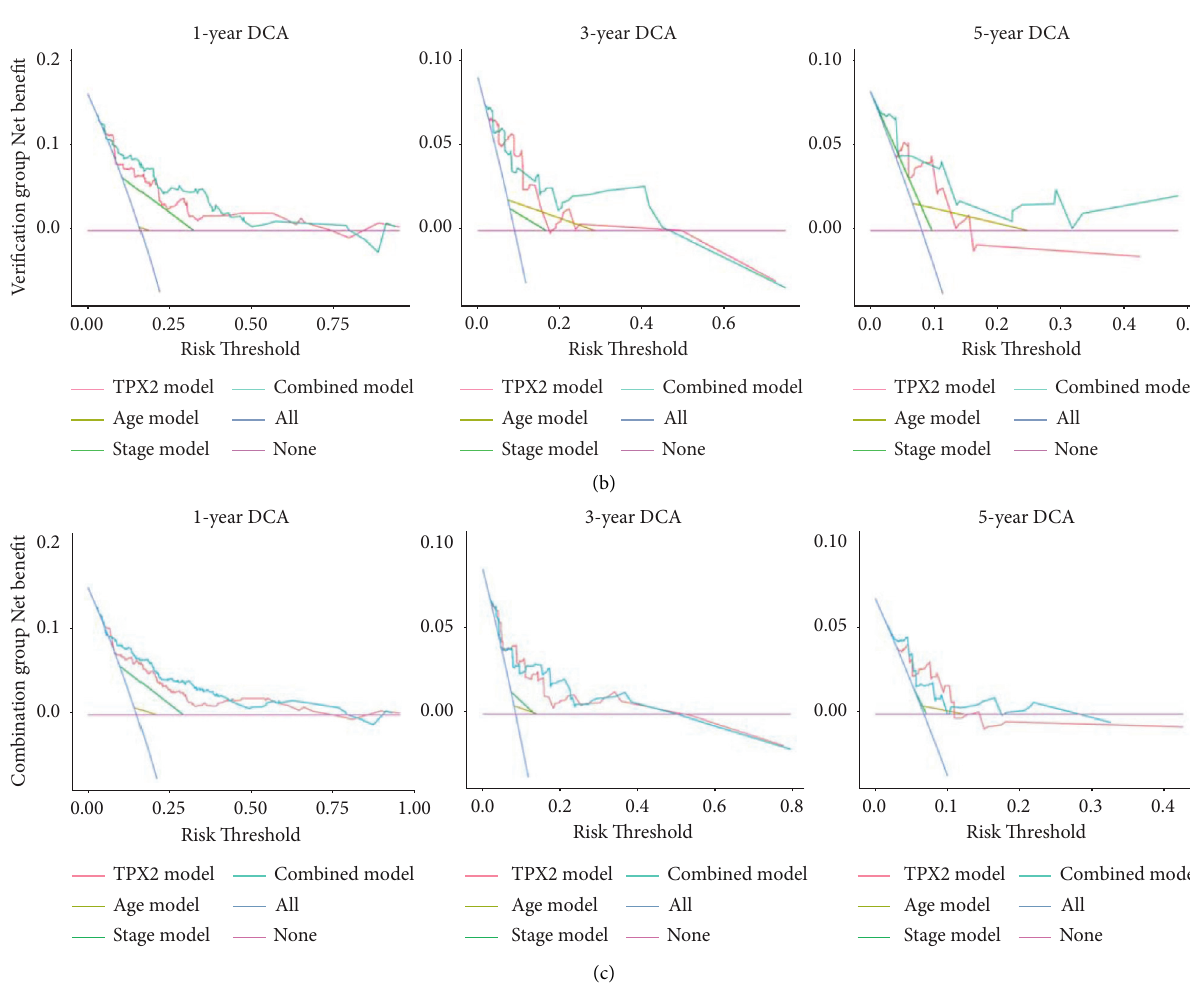
Figure 6: DCA curves of the nomogram. A comparison of the DCA curves for 1-, 3- and 5-year overall survival in EC patients among the training group, verification group and combination groups, respectively. The none plot represents the assumption that no patient presented 1-, 3- or 5-year survival; whereas all plot represents the assumption that all patients presented 1-, 3- or 5-year survival at a specific threshold probability. The x -axis represents the threshold probabilities, and the y -axis shows the net benefit. DCA: decision curve analysis; EC: endometrial